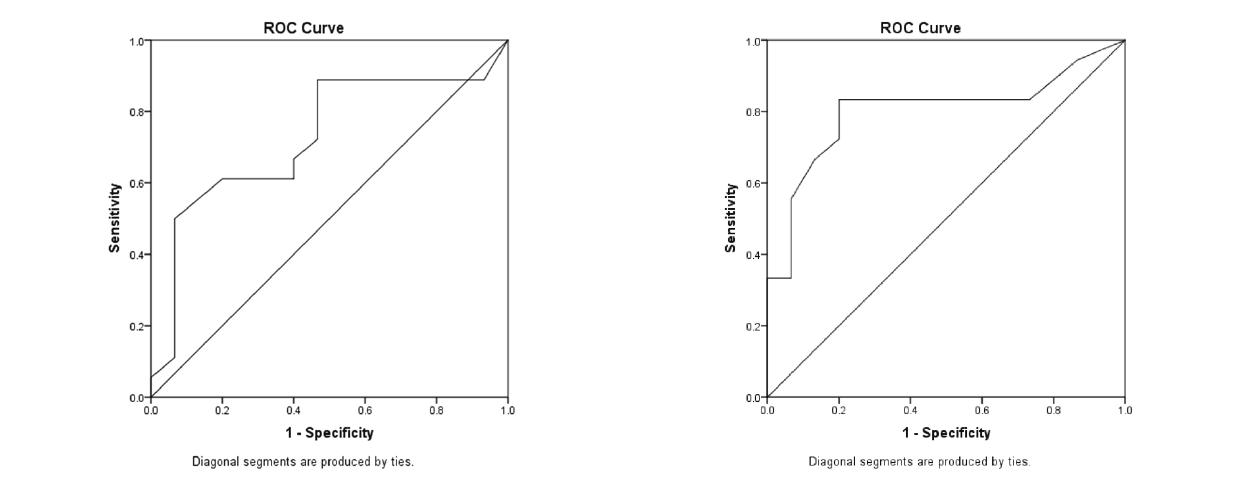
Figure 1: The prognostic value of the Mini-Mental State Examination for discharge event